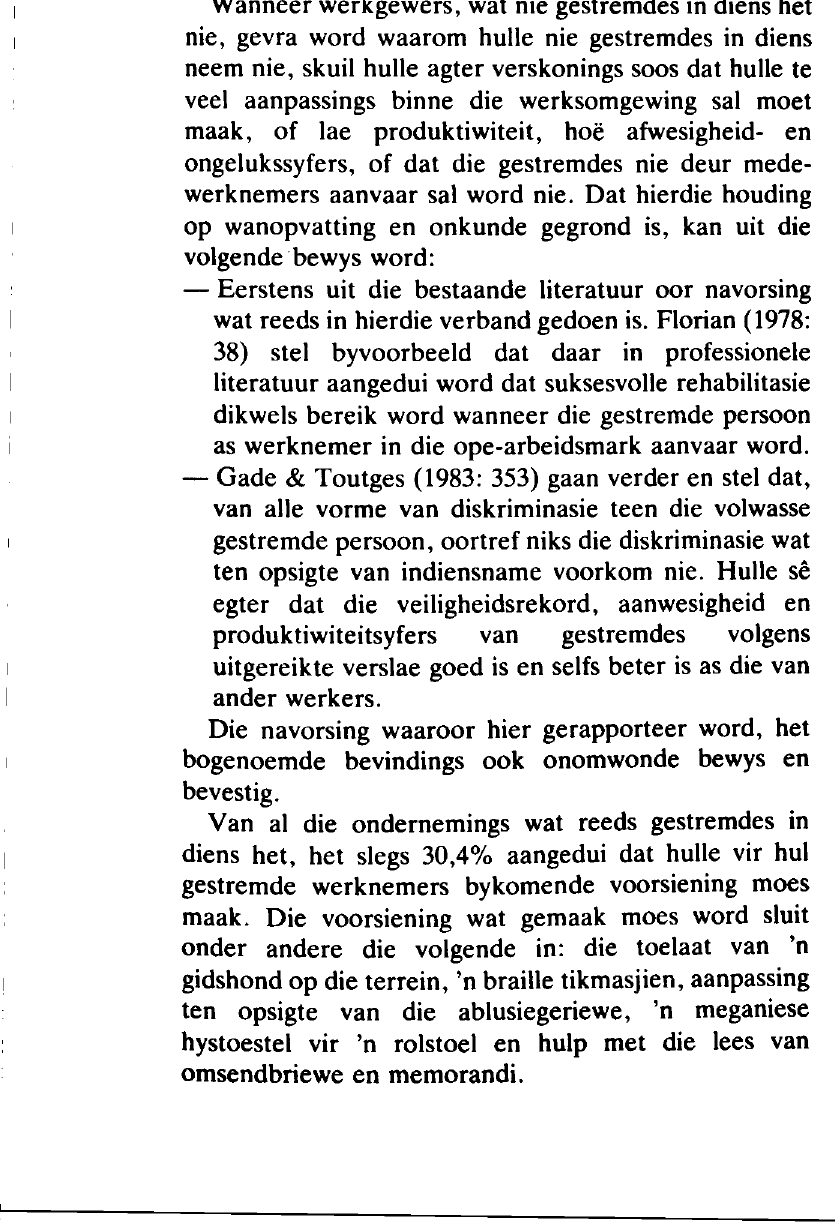
Figuur 2b Sosiale aanpasbaarheid van gestremdes